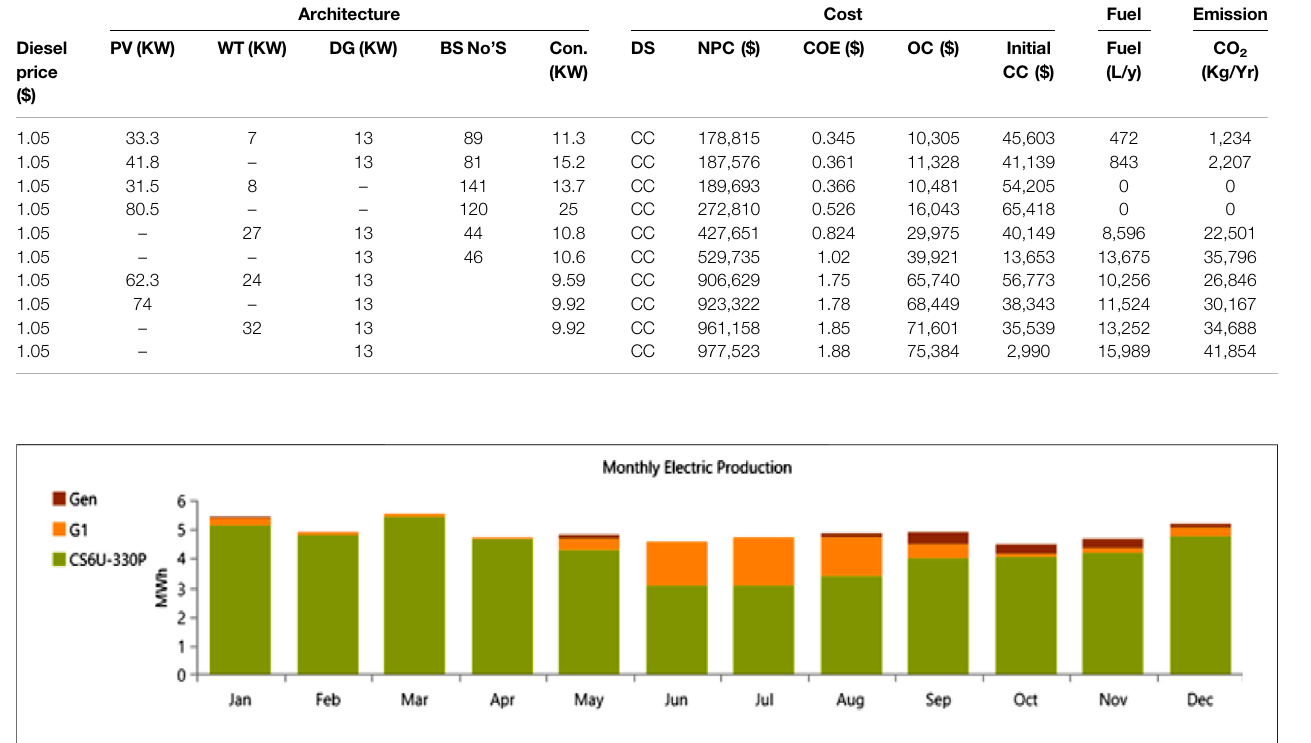
FIGURE 9 | Monthly electricity production from solar, wind, and diesel generators (Ooty).